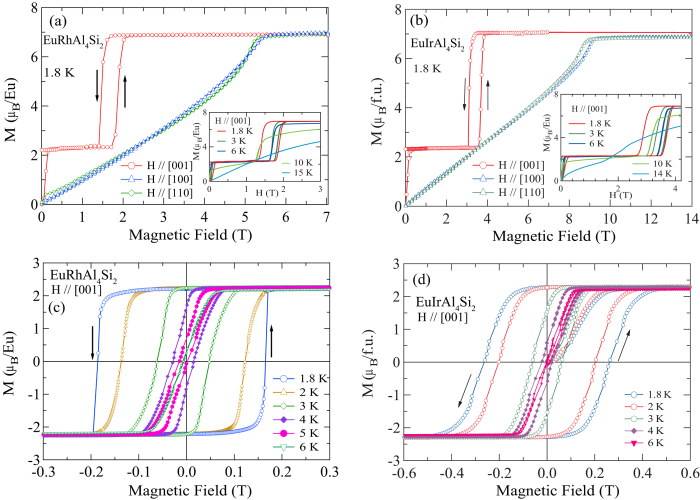
M vs H for (a) EuRhAl4Si2 and (b) EuIrAl4Si2 at 1.8 K for H in the ab-plane and along [001] and at selected temperatures for H along [001](insets) (c). Low field hysteresis showing the coercive field in EuRhAl4Si2 (c) and EuIrAl4Si2 (d).